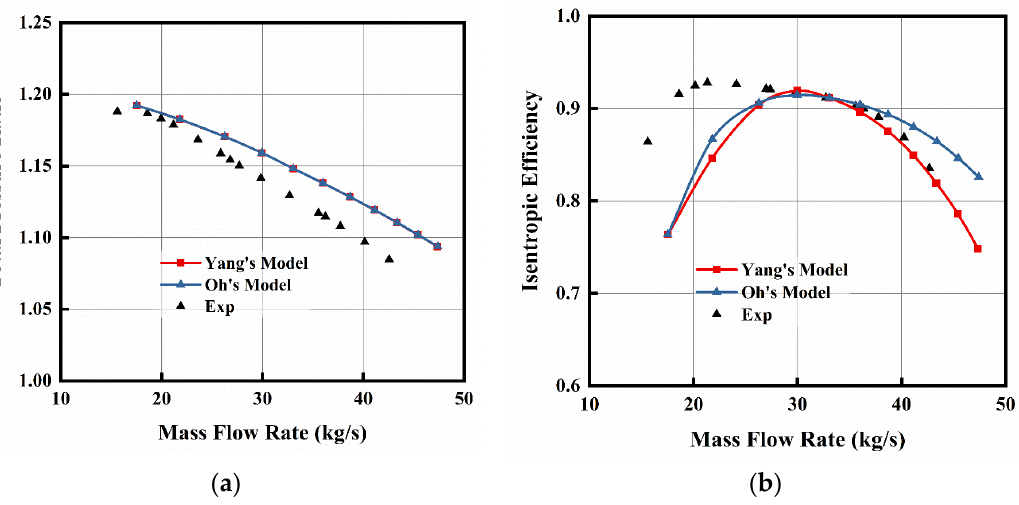
Figure 4. Performance characteristics of LSCC. ( a ) Total pressure ratio; ( b ) isentropic efficiency. Table 3. Contributions of different losses for the LSCC